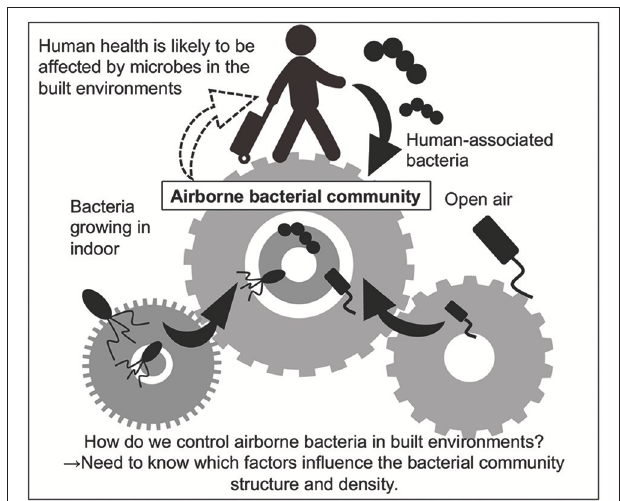
FIGURE 1 | Overview of the present review. Human health is probably affected by bacteria in built environments, because people spend approximately 90% of their lives there. Humans and outdoor air are likely to be the major sources of airborne bacteria as well as bacteria growing in indoors (Burrows et